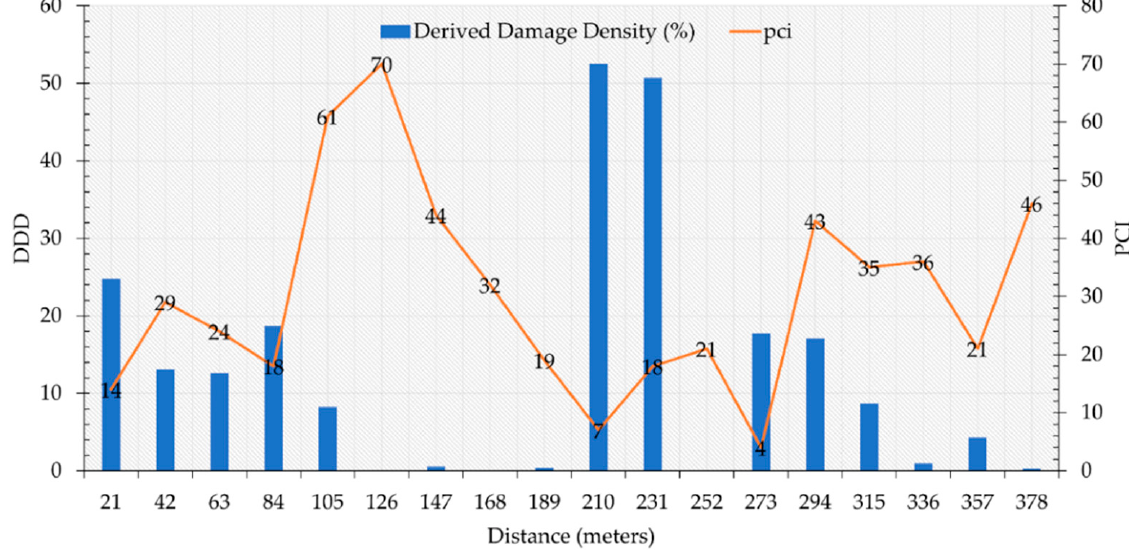
Figure 6. The Image Distress Quantity variation in Section 1.